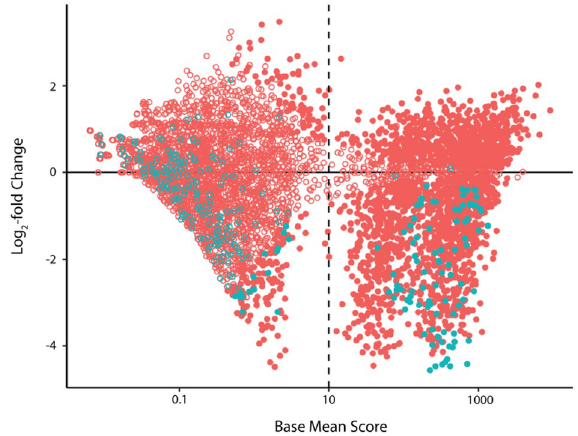
Figure 4. phPAI-1 uPA-selected libraries are enriched in variants that retain their inhibitory function and depleted of those without inhibitory activity. An MA plot 33 of base mean score (average of counts in the input and selected libraries) vs. log 2 -fold change is shown, with missense mutations in pink and nonsense variants in blue. Variants with p adj < 0.05 are shown as closed circles, while those that do not meet this significance threshold are shown as open circles. A base mean score greater than 10 was also set as a threshold for determining significance. This figure was generated using Adobe Illustrator 2021 version 25.2.3 and the ggplot2 package version 3.3.3 for RStudio version